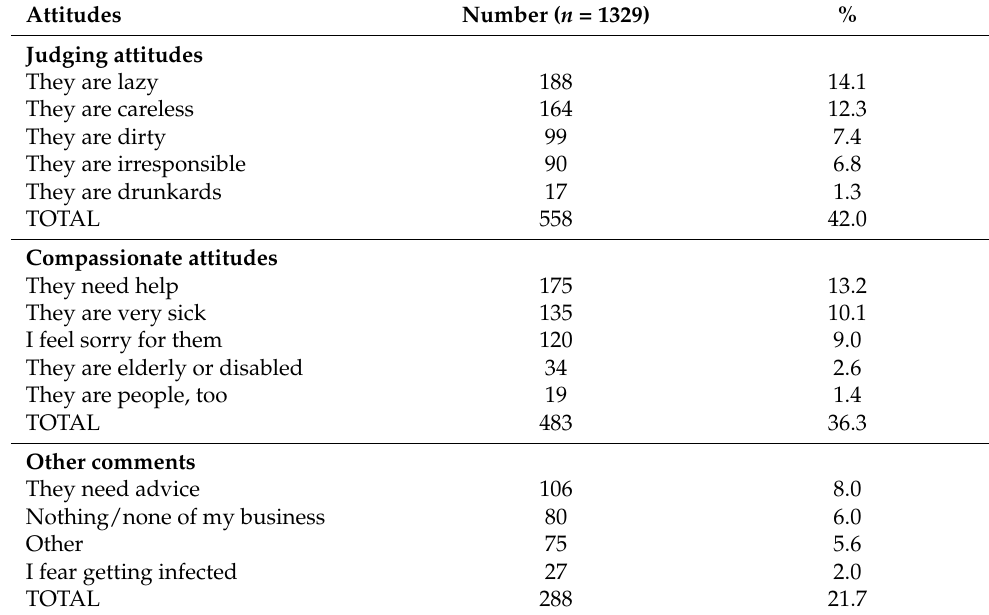
Table 4. Judging and compassionate attitudes towards people with tungiasis (open-text